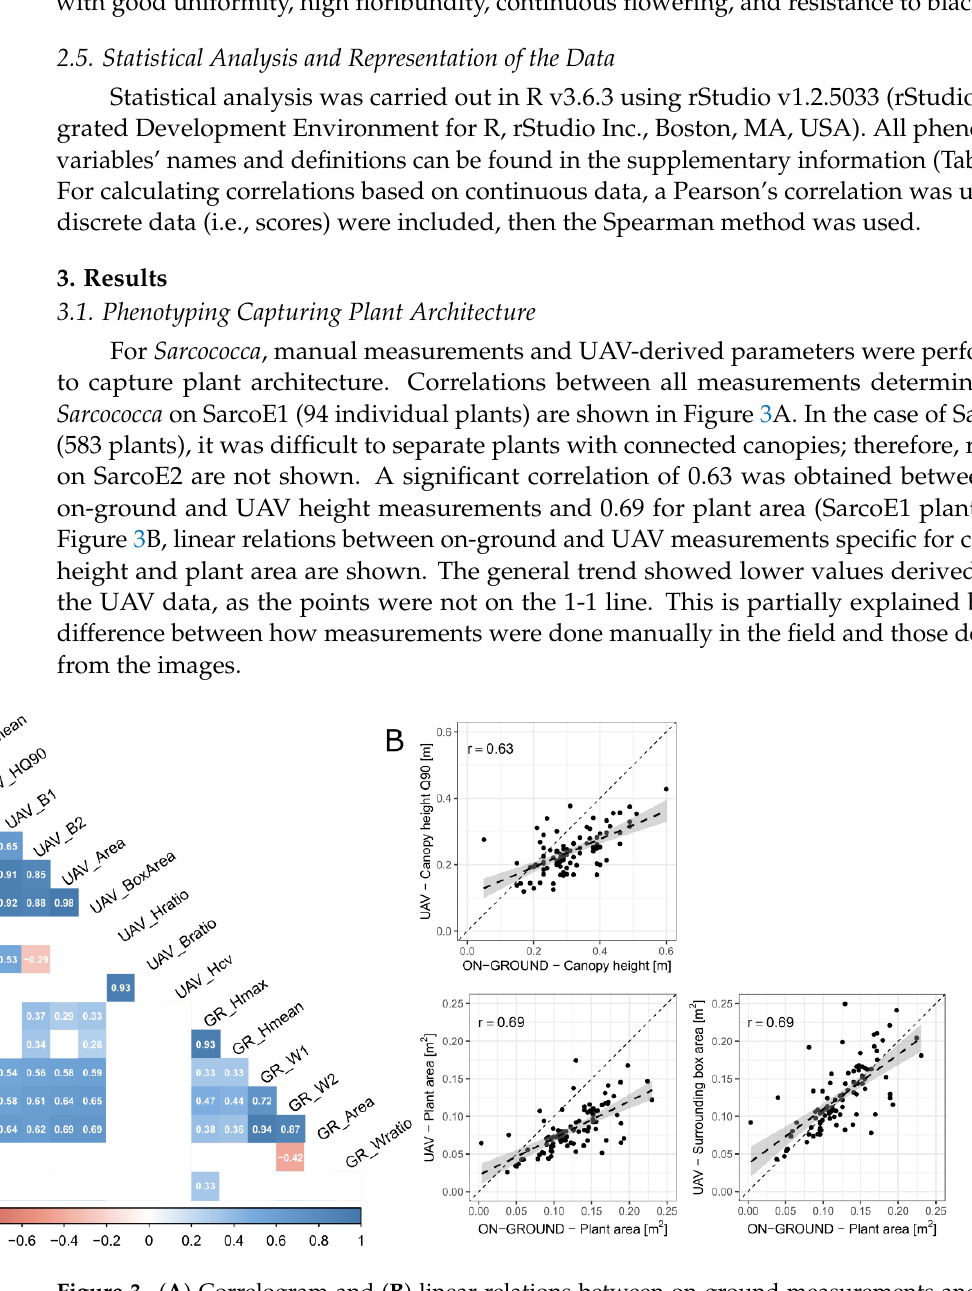
Figure 3. ( A ) Correlogram and ( B ) linear relations between on-ground measurements and UAV- derived plant architectural (plant height and width) parameters in Sarcococca , SarcoE1 (n = 94 plants). For the abbreviations, see Table S2.